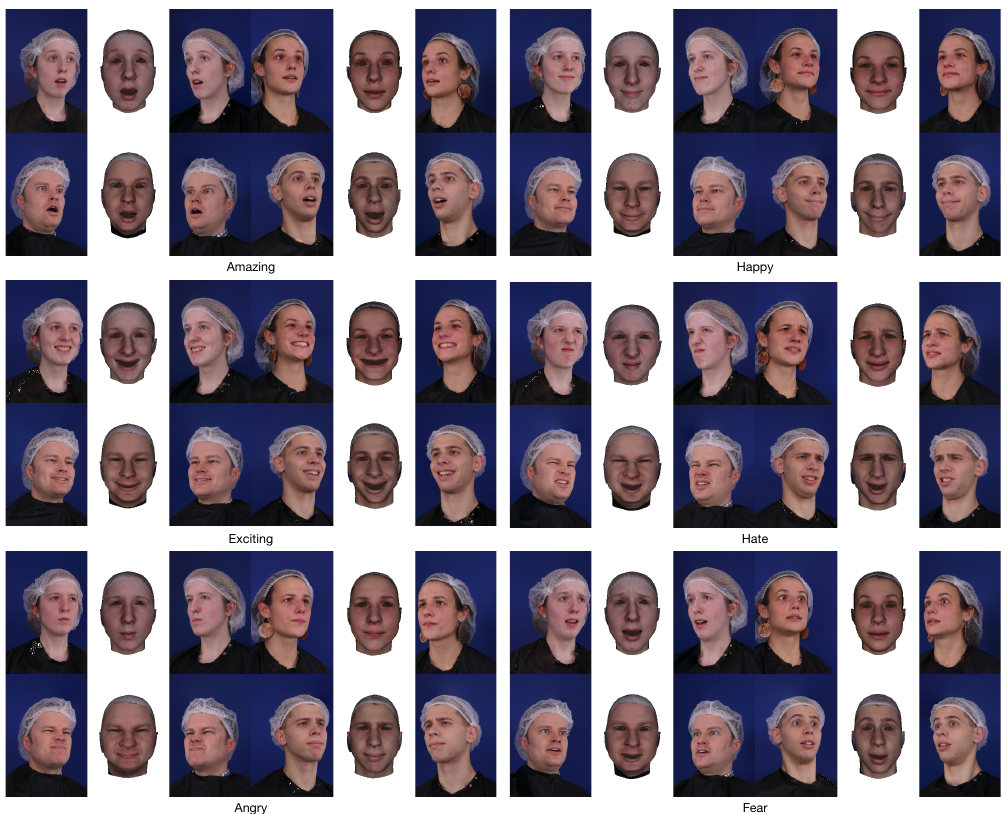
Figure 11. Some reconstruction results of six emotional